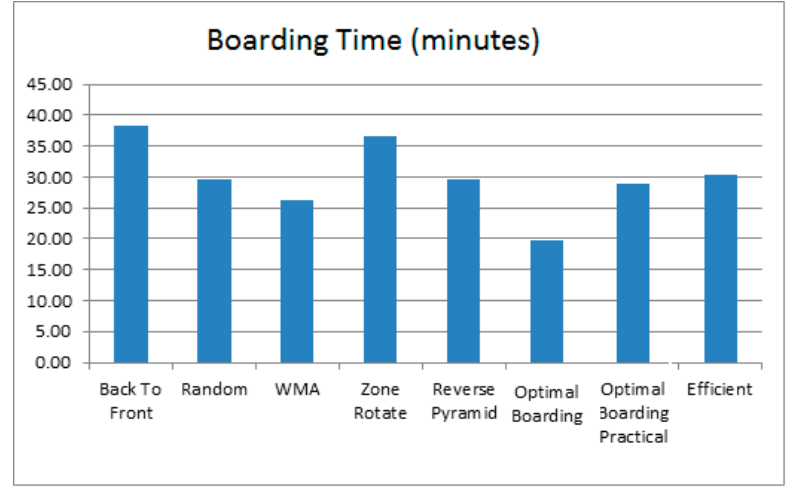
Figure 30. Boarding time with fixed walking delays.